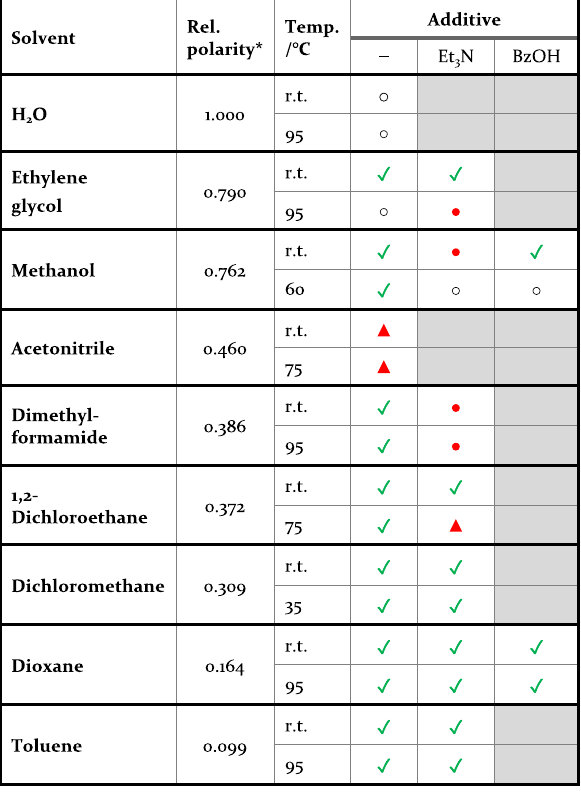
Table 1. Screening of the stability of AuNP/Si supports in different solvents, with and without the addition of base/acid a,b . a General procedure: A nanoparticle support was immersed into 1 mL solvent or 1 mL solvent and 0.05 mM triethylamine (Et 3 N) or 1 mL solvent and 0.05 mM benzoic acid (BzOH) for 24 h at room temperature or slightly below the boiling temperature of the respective solvent or to a maximum of 95